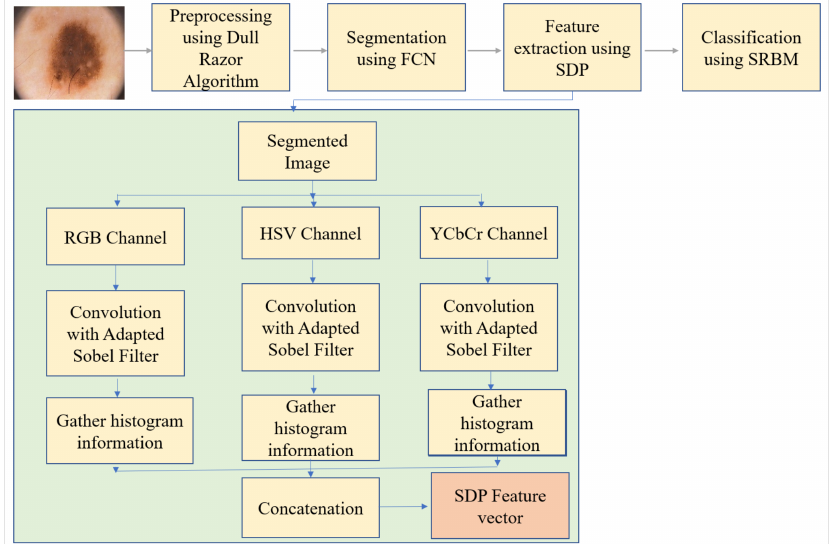
Figure 2. Proposed framework of the current